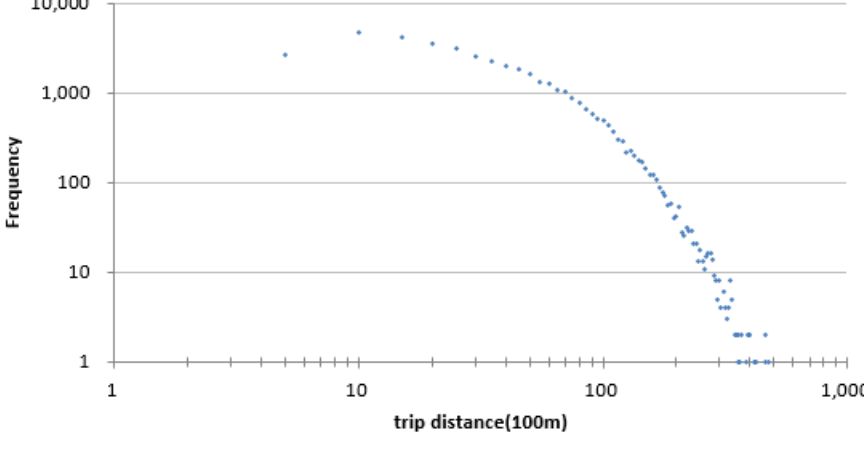
Figure 4. A log-log plot of the distance distribution of trips on 2 June.